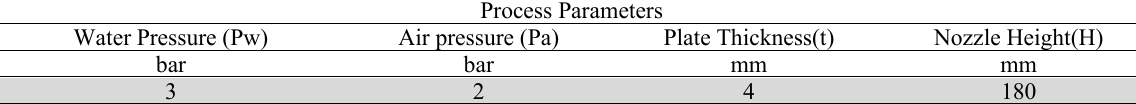
Predicted Optimal